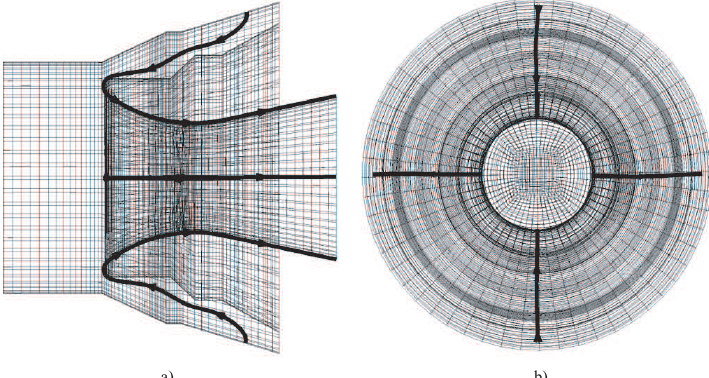
Figure 17. Streamlines near the rear nozzle head for cylindrical channel ( α = 0 ◦ ): side view ( a ) and face view ( b ).